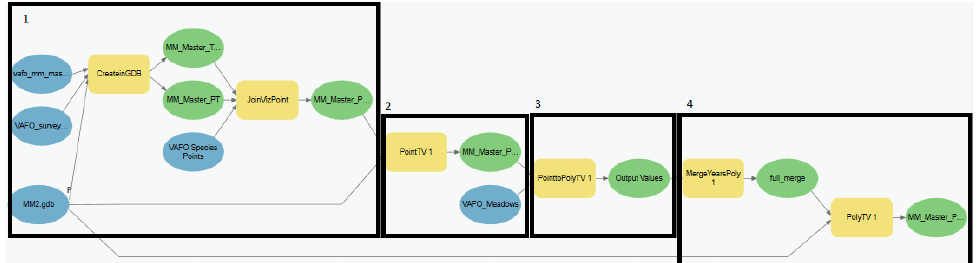
Figure 4. The ArcPro modelbuilder contains the four major submodels. Submodel 1 designates the import of observation data and joining the data to point geometry; submodel 2 designates the calculation of species benchmarks for points; submodel 3 designates the averaging of point values by meadow; and submodel 4 designates the calculation of species benchmarks for meadows.